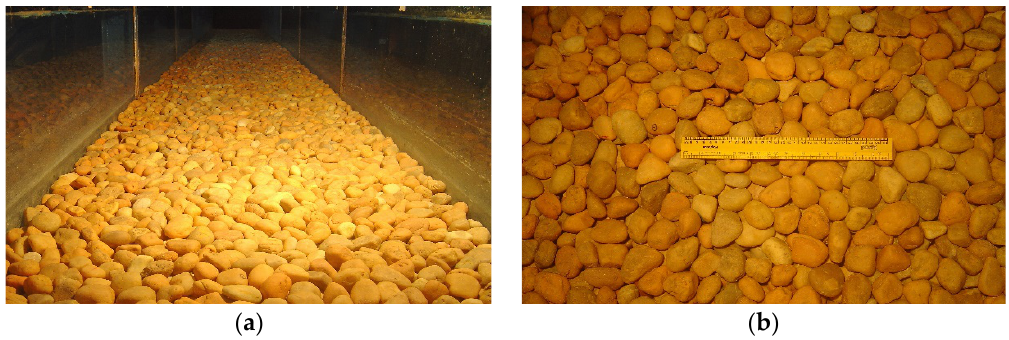
Figure 2. Photograph of an SGB in a laboratory flume ( a ); and a close view ( b ).